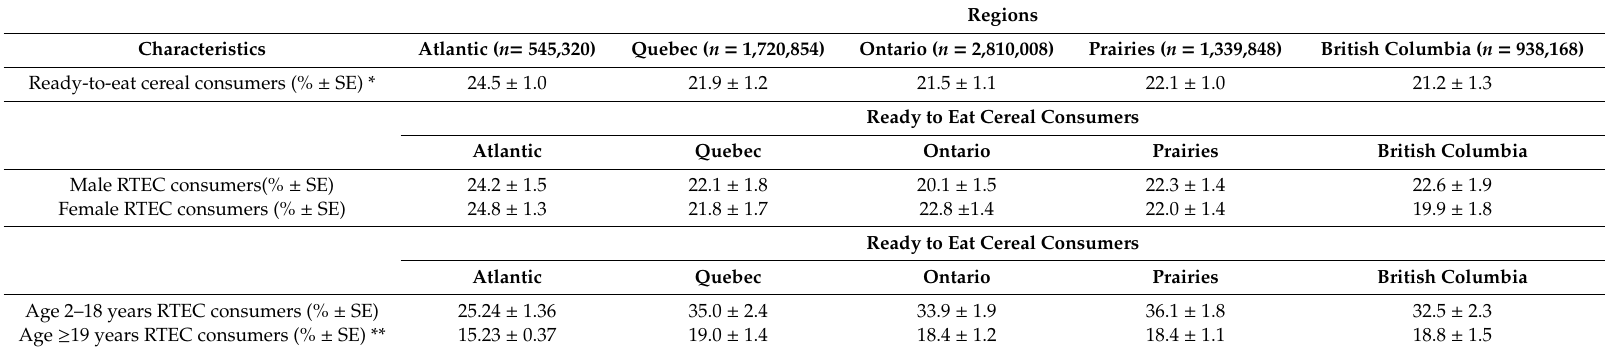
Table 2. Distribution of Ready-To-Eat Cereal Consumers by Regions, Sex, and Age in Canada 1 .